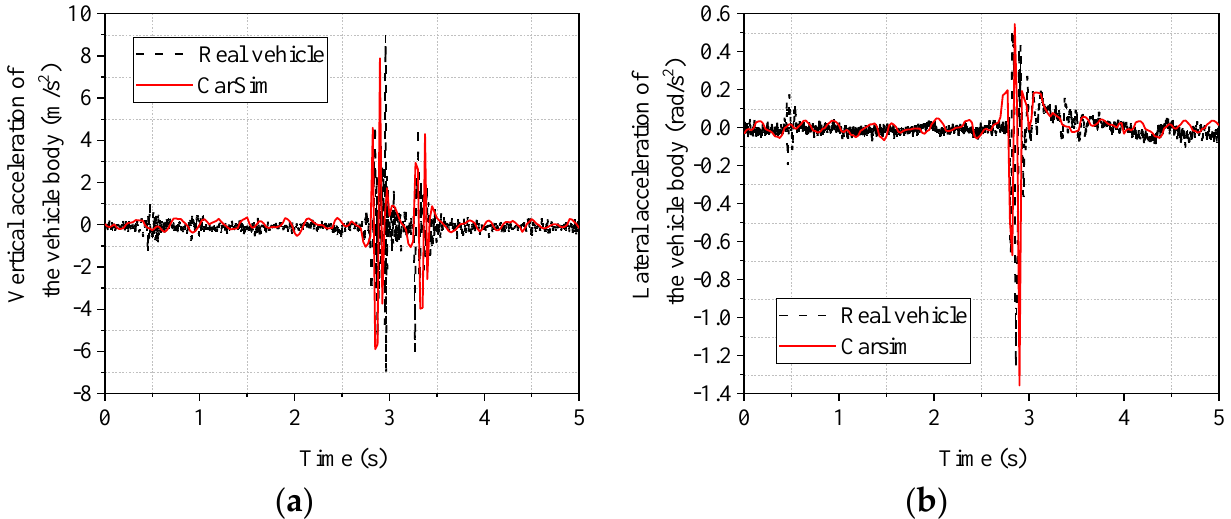
Figure 9. Trapezoidal speed bump body response. ( a ) vertical acceleration of the body; ( b ) lateral camber acceleration of the body.